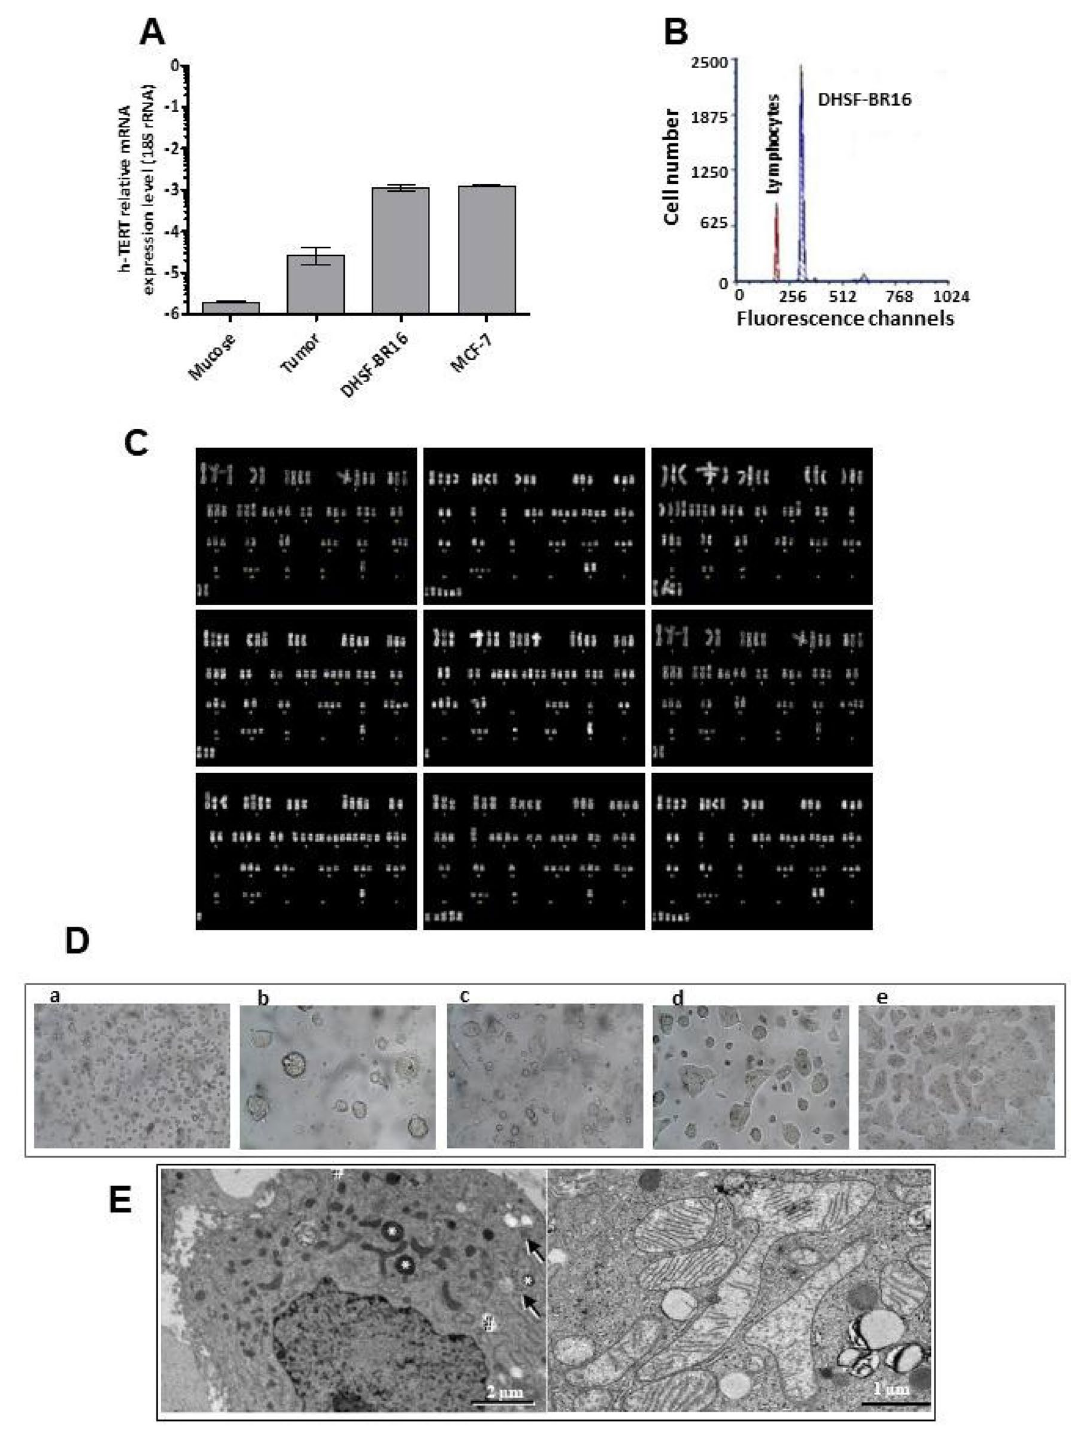
Figure 1. h-TERT gene expression, cytogenetic, morphologic and growth characteristics of DHSF-BR16 cells. ( A ) mRNA expression levels of h-TERT in DHSF-BR16 and MCF-7 cells, breast cancer tissue and the corresponding normal tissue. ( B ) Aneuploidy of DHSF-BR16 cells by the DNA analysis. DHSF-BR16 and human peripheral blood lymphocytes G 0 /G 1 fluorescence channel is 318 and 195, respectively. ( C ) Representative karyotype from DHSF-BR16 cell line with different number of chromosomes, various chromosomal rearrangements and unidentifiable marker chromosomes. Chromosome analysis was performed at 10th and 30th passages with similar findings. ( D ) First subculture of DHSF-BR16 established cell line: (a) cells splitted; (b) 1 day from split; (c) 4 days from split; (d) 7 days from split; (e) 10 days from split, showing patchy appearance. × 40 magnification (a), × 200 magnification (b–e). ( E ) DHSF-BR16 cell morphology by electron microscopy: left, isolated cell, with short, sparse microvilli on the cell surface. Asterisks: electron dense lysosomes; hashtags: lipid droplets; arrows: arrays of glycogen particles; right, mitochondria round or elongated up, occasionally branched. There were very large mitochondria, elongated and more than 3 µm long and with irregular dilations up to 2 µm, with variable amount of